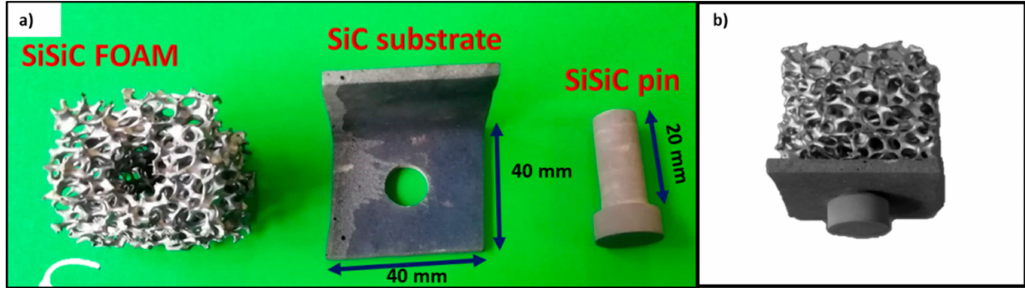
Figure 11. Parts of the mock-up of the solar receiver: the SiSiC foam, the “L” shaped SiC substrate, the SiSiC pin ( a ), and the joined mock-up ( b